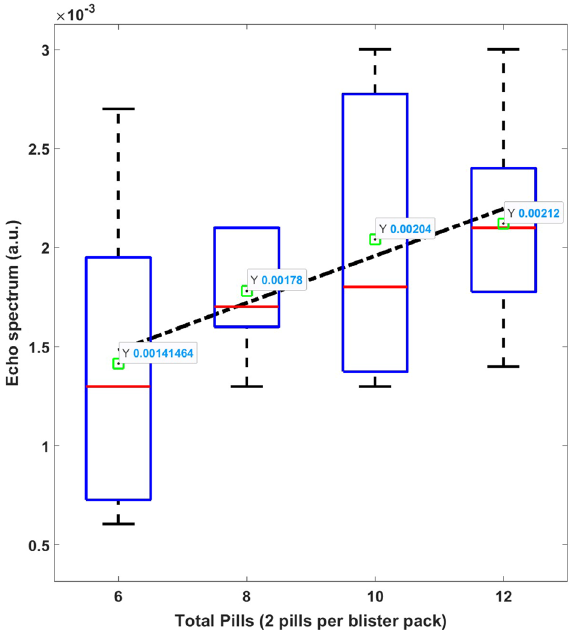
Figure 15. Measured NQR signal amplitudes for acetaminophen pills (325 mg each caplet) packaged within 4 cm × 4 cm blister packs.